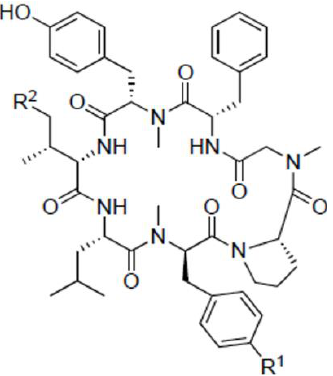
Figure 16. Structure of asperterrestide A